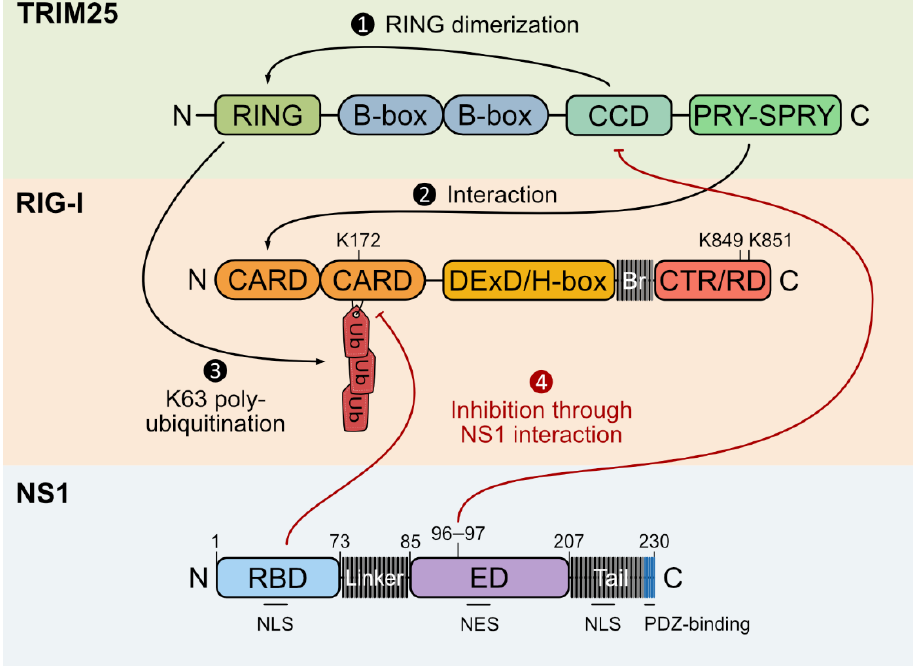
Figure 3. Schematic representation of TRIM25, RIG-I and NS1 protein structures and interactions. Upon infection, TRIM25 CCD first mediates RING domain dimerization (1) and subsequent complete TRIM25 dimerization, allowing interaction between TRIM25 PRY-SPRY domain and RIG-I first CARD (2). TRIM25 RING domain then mediates K63-linked poly-ubiquitination of the lysine 172 (K172) on RIG-I second CARD (3), leading to antiviral response activation. In turn, IAV NS1 protein can inhibit these two proteins (red arrows) (4). NS1 RBD from 1918 H1N1 strain directly binds to and inhibits poly-ubiquitination of RIG-I second CARD, while amino acids 96 and 97 in ED interact with TRIM25 CCD, therefore inhibiting TRIM25 dimerization.